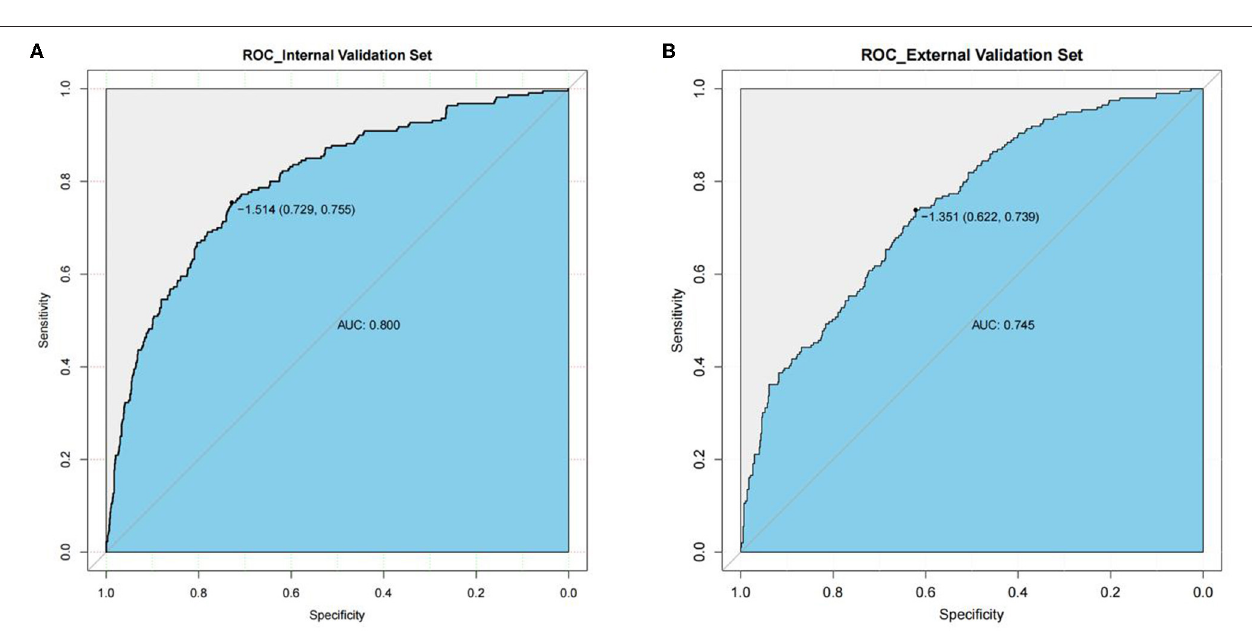
Several studies have shown that patients with SBP have higher CRP levels than patients without SBP (26–29). In this study, patients with SBP and abnormal CRP levels accounted for 56.78%, which was significantly higher than patients with non-SBP 30.38%, consistent with previous studies. After trauma